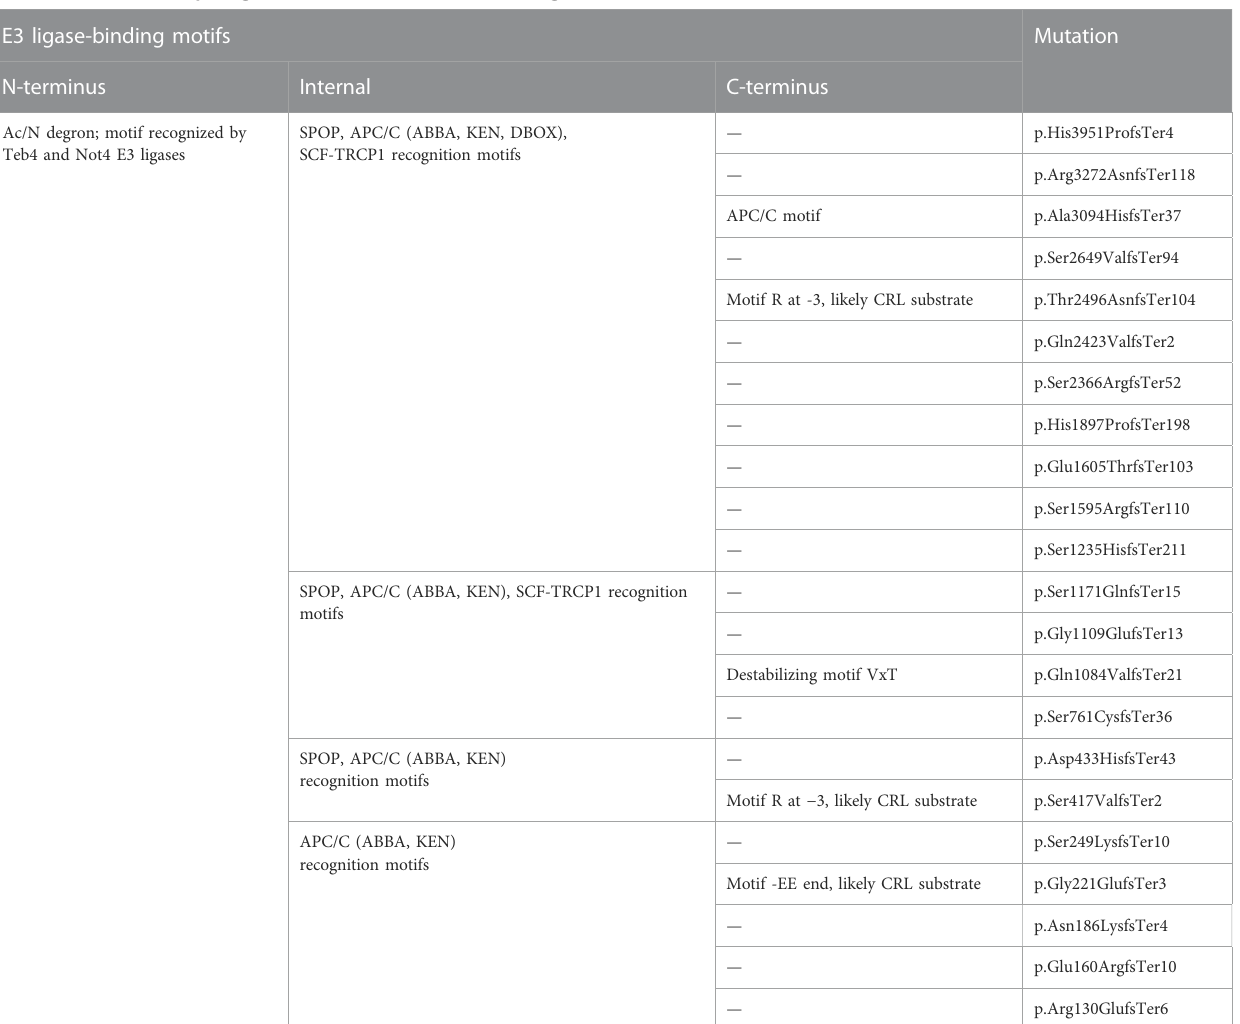
TABLE 3 List of recurrent pathogenic frameshift mutation and their degron motif. E3 ligase-binding motifs Mutation